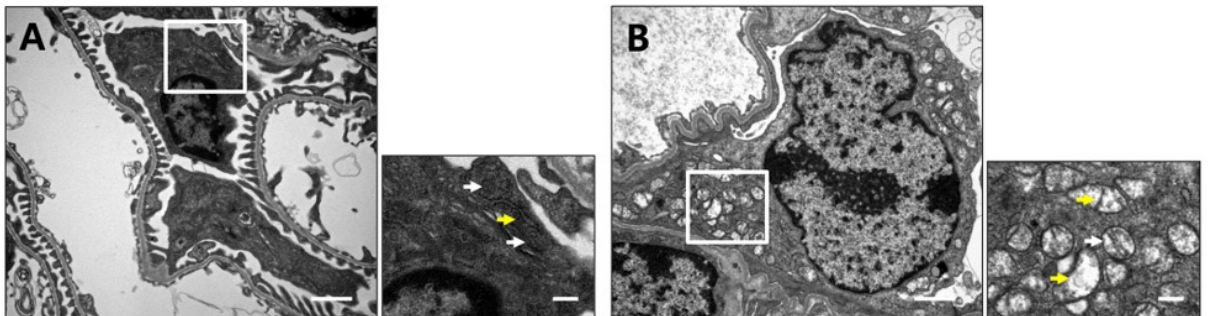
Figure 4. Podocyte-specific CRIF1 deficiency causes mitochondrial structural abnormalities. Transmission electron micrographs of renal cortex sections from 10-week-old CRIF1 ctrl mice ( A ) and CRIF1 pdKO ( B ) mice. The smaller panels show higher magnifications of the boxed areas in the larger panels. The white arrows indicate mitochondria. The yellow arrows indicate cristae of mitochondria Scale bars, 2 µ m (large panels) and 0.5 µ m (small panels).